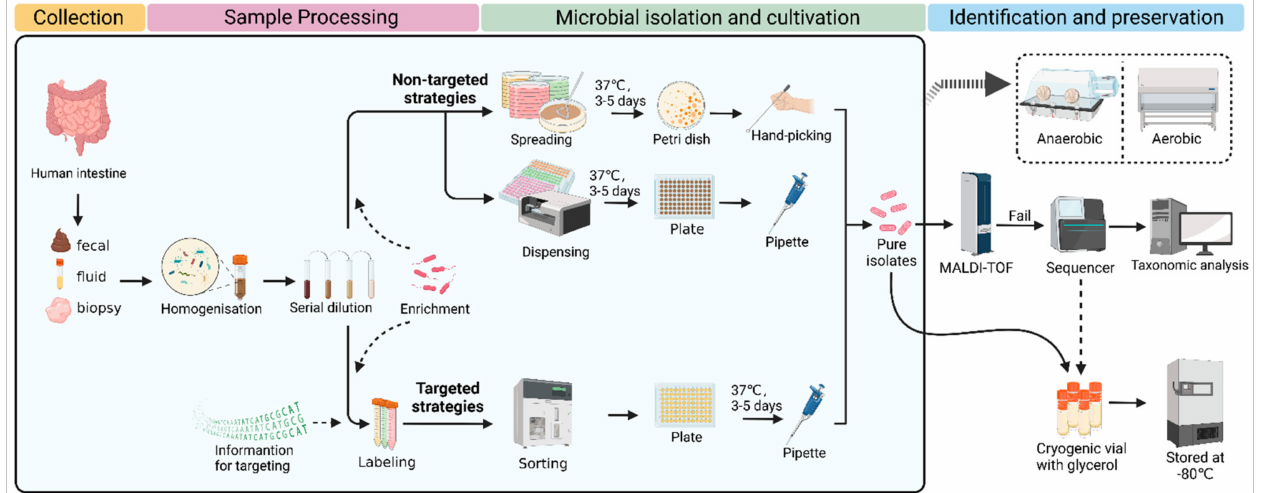
Figure 1. Schematic representation of nontargeted and targeted strategies for culturomics. The nontargeted strategies are usually to obtain as many species as possible in a sample, while the targeted strategies are more likely to sort certain microorganisms of interest. Created with